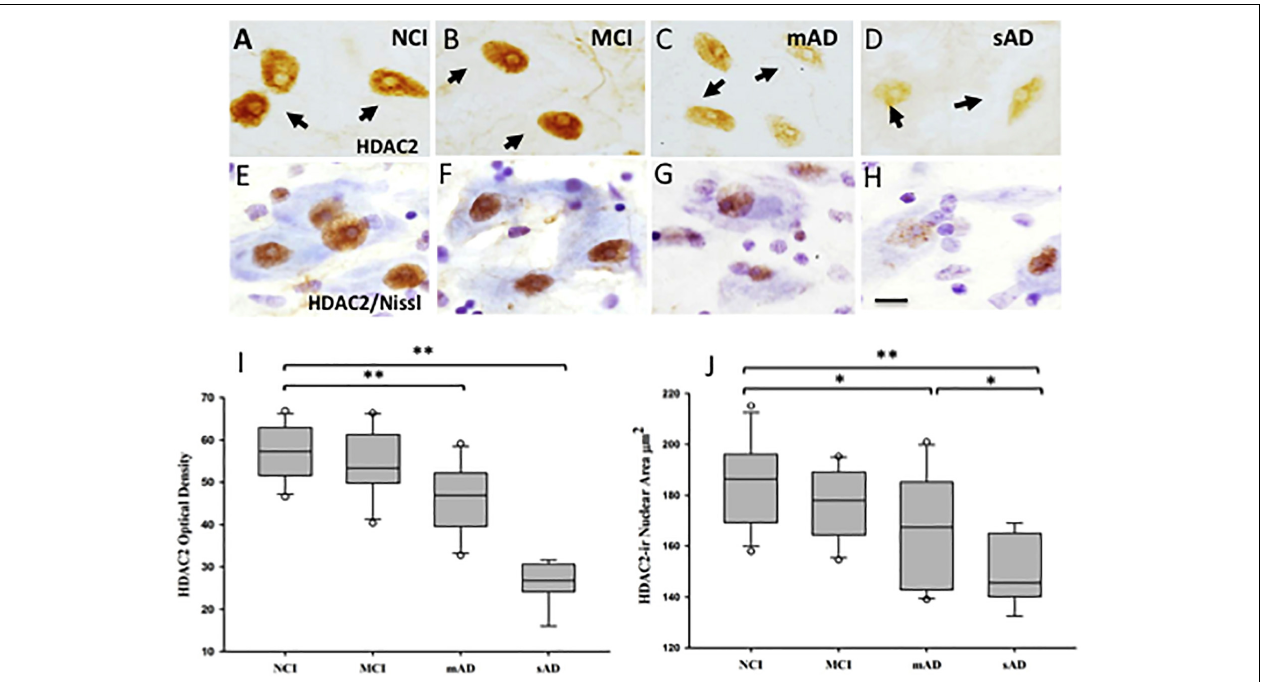
FIGURE 10 | Photomicrographs of single HDAC2 (A–D) and HDAC2 and cresyl violet dual stained (E–H) nucleus basalis neurons. Nuclei positive for HDAC2 lost their rounded shape and were displaced to the periphery of the soma in the MCI, mAD, and sAD groups. (I) Box plots showing HDAC2-ir was significantly decreased in mAD compared to NCI and MCI ( p < 0.001), and sAD compared to NCI, MCI, and mAD ( p < 0.001). (J) Box plots showing area of HDAC2-ir nuclei was significantly decreased in mAD compared to NCI ( p = 0.03) and in sAD compared to NCI ( p < 0.001), MCI ( p < 0.001), and mAD ( p = 0.04) groups. Circles in box plots indicate outliers. ∗ p < 0.05; ∗∗ p < 0.001. Scale bar: 10 µ m. Reproduced from Mahady et al.